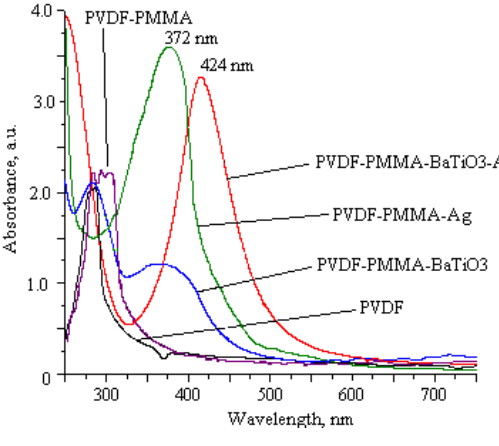
Figure 2. Comparison of absorbance spectra of PVDF-based films and films with silver